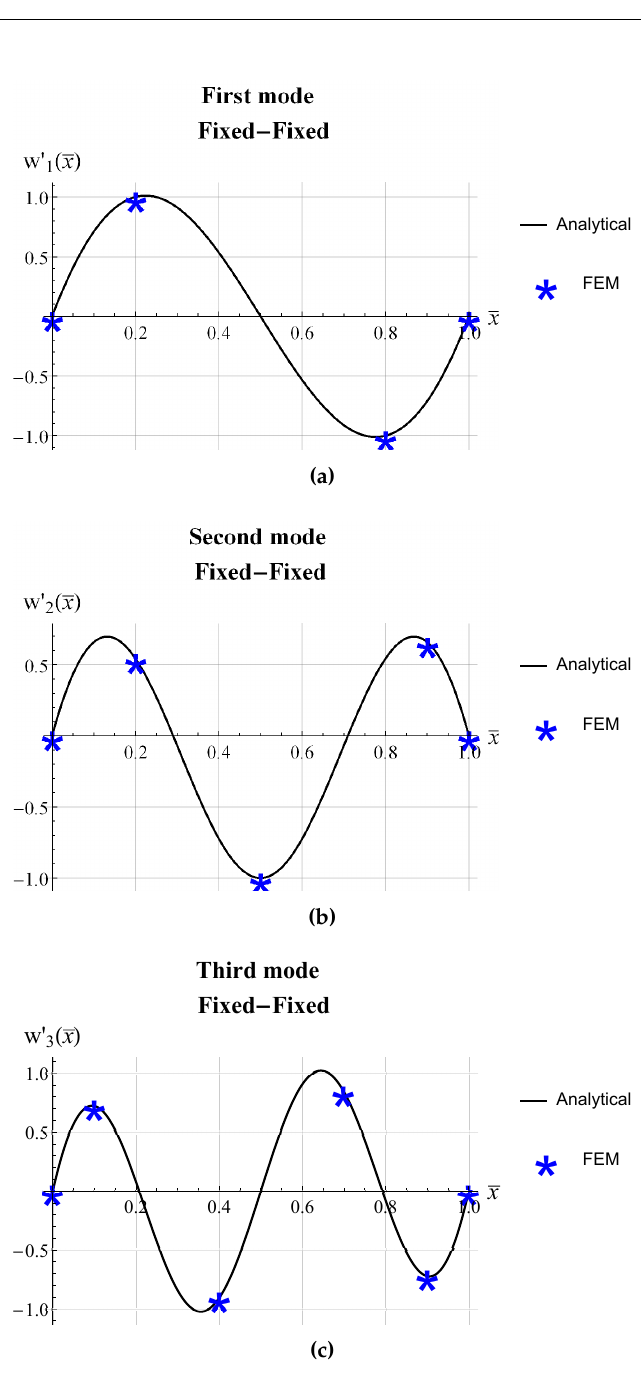
Figure 7. First derivatives of the first three modes for fixed-fixed boundary condition: ( a ) first mode, ( b ) second mode, and ( c ) third mode. The FEM results highlight the optimal location of the voltage sign switch (illustrated with blue